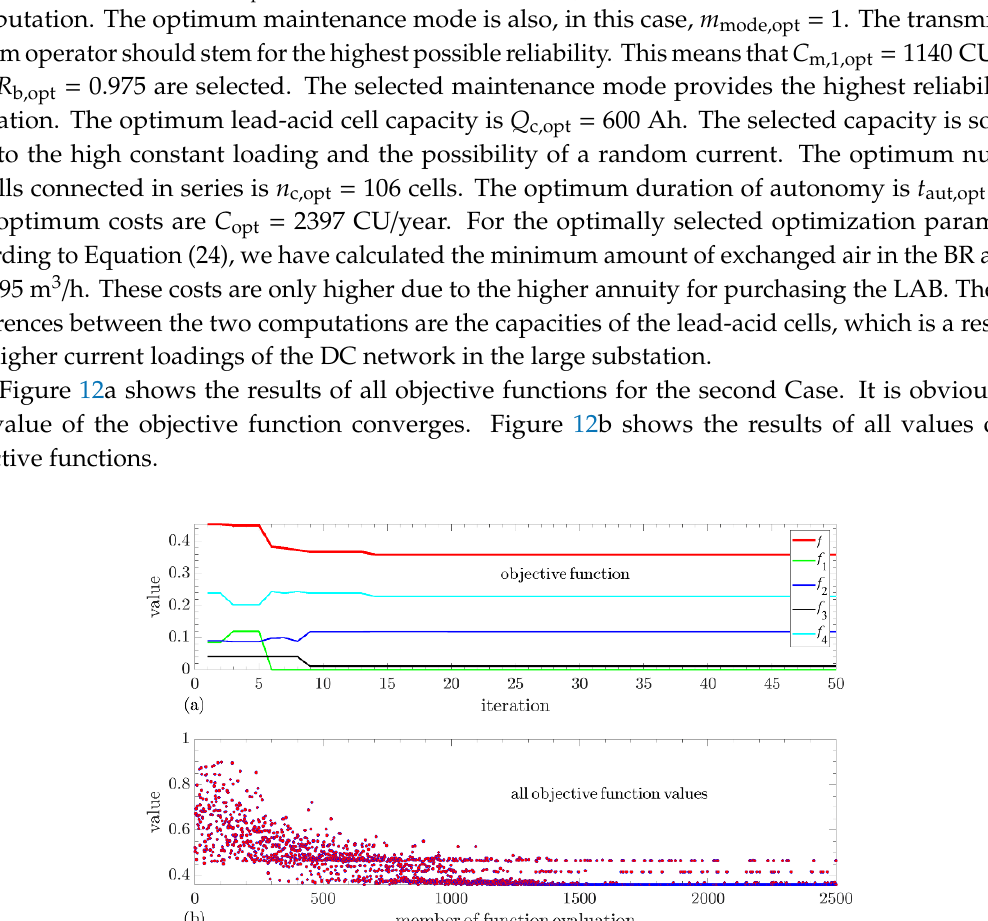
Figure 13. The results of optimization parameters in various iterations for a large substation. 6. Comparison between the Conventional and New Selection Method Using Optimization For Case 1, the selected capacity of lead-acid cells is Q c = 300 Ah using the conventional selection method for the intended autonomy of operation. Using the new method, the selected capacity after optimization is Q c = 250 Ah for the estimated LAB autonomy of 8 h, which is one level lower than the selection according to the conventional method. The number of lead-acid cells is n c = 106 cells according to the new method. According to the conventional method, it is n c = 104 cells. These selections satisfy all the technical requirements of the Standard [8]. Selection according to the new method is cost effective. The highest level of reliability and the lowest H 2 emissions in the BR were reached. According to the conventional method, the minimum amount of required air exchange in the BR is Q air = 31.73 m 3 /h, which is 46% more than the selection using the optimization method. In the event of a failure on the HVAC system for the BR, the gas concentration would rise earlier, with the same mode of operation. Maintenance and explosion protection requirements are part of the